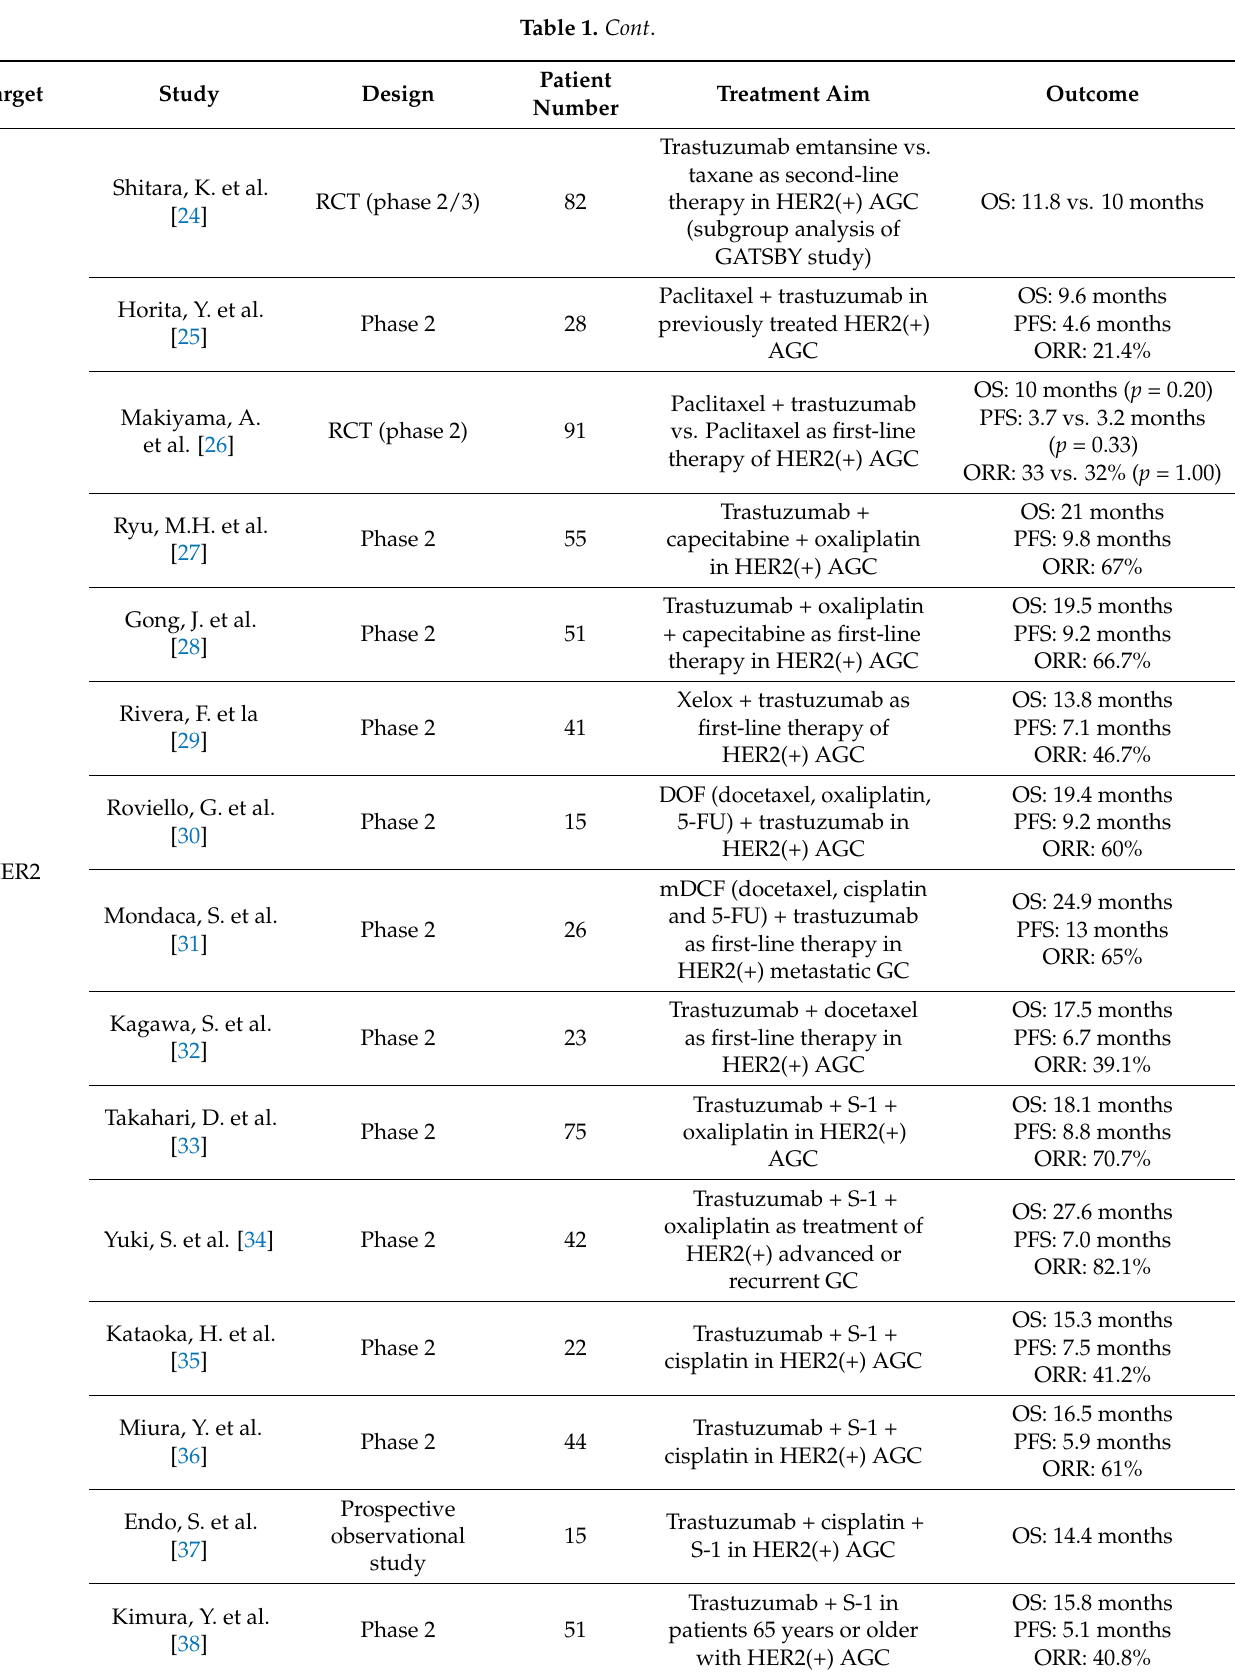
Table 1. Cont . Treatment Aim Outcome Trastuzumab emtansine